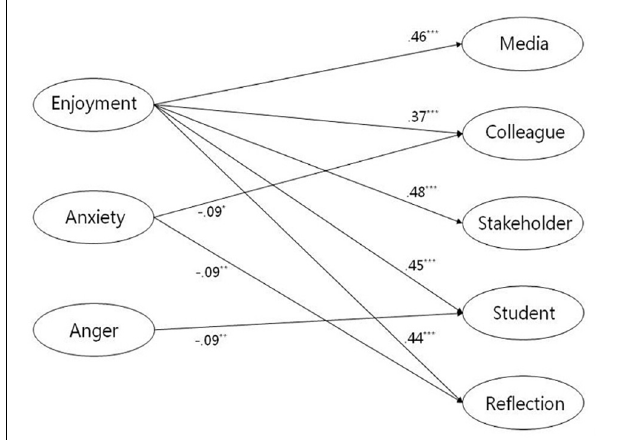
TABLE 4 | Links between teaching experience and the five ITL